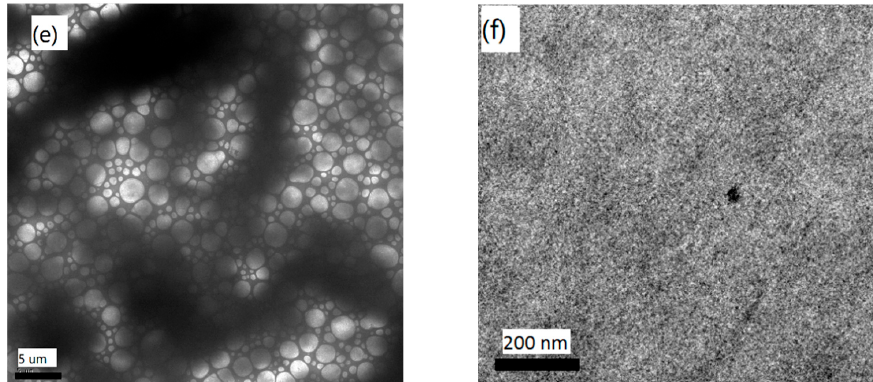
Figure 4. ( a ) DSC curves of P-PDI; ( b ) atomic force microscopy (AFM) height images of PTB7-Th:P-PDI blend films; ( c ) scanning electron microscope (SEM) images of PTB7-Th:PDI blend films (Scale bar: 500 nm); ( d ) SEM images of PTB7-Th:P-PDI blend films (Scale bar: 500 nm); ( e ) transmission electron microscopy (TEM) images of PTB7-Th:PDI blend films (Scale bar: 5 μ m) ( f ) TEM images of PTB7-Th:P-PDI blend films (Scale bar: 200 nm).